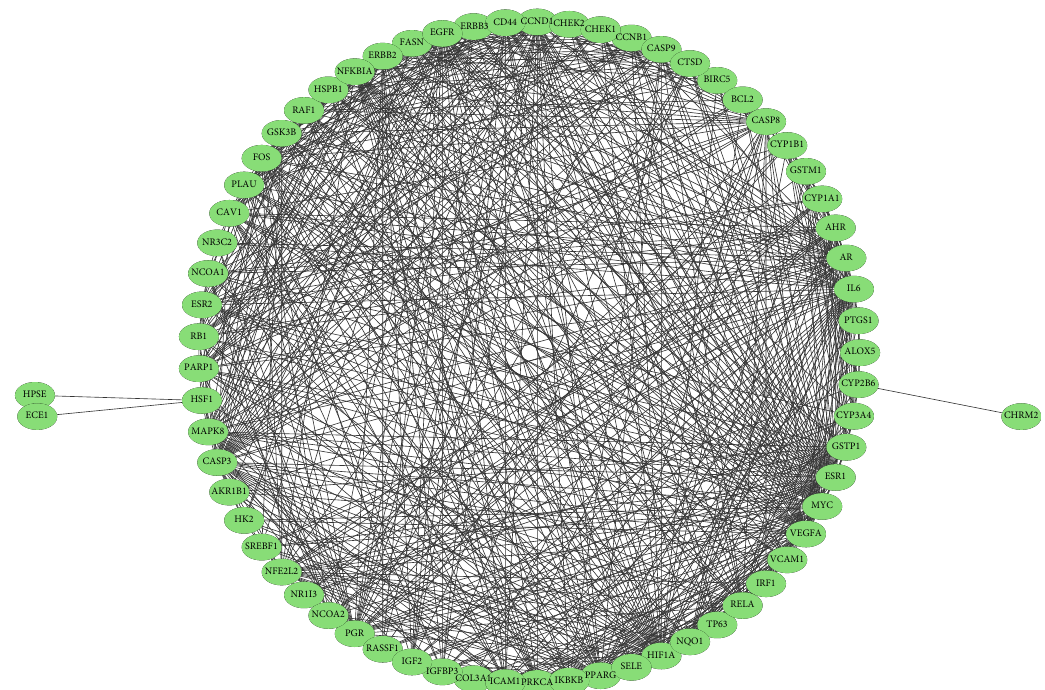
Figure 4: PPI network construction for 70 CS and thin endometrium common